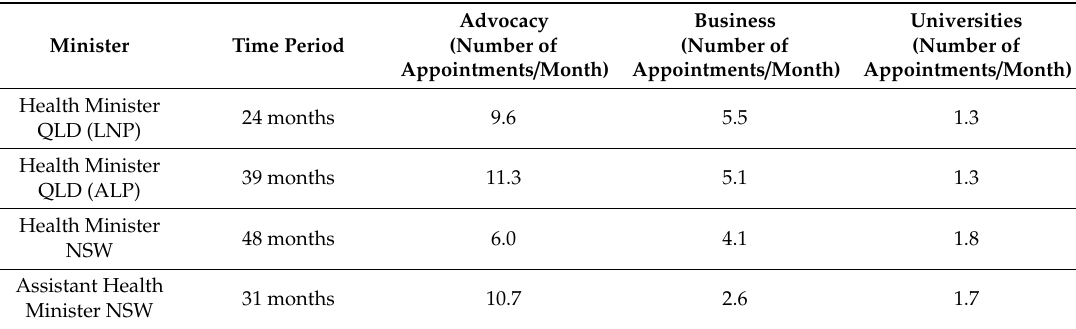
Table 2. Average numbers of recorded appointments with interest groups in ministers’ diaries, per month (January 2013–June